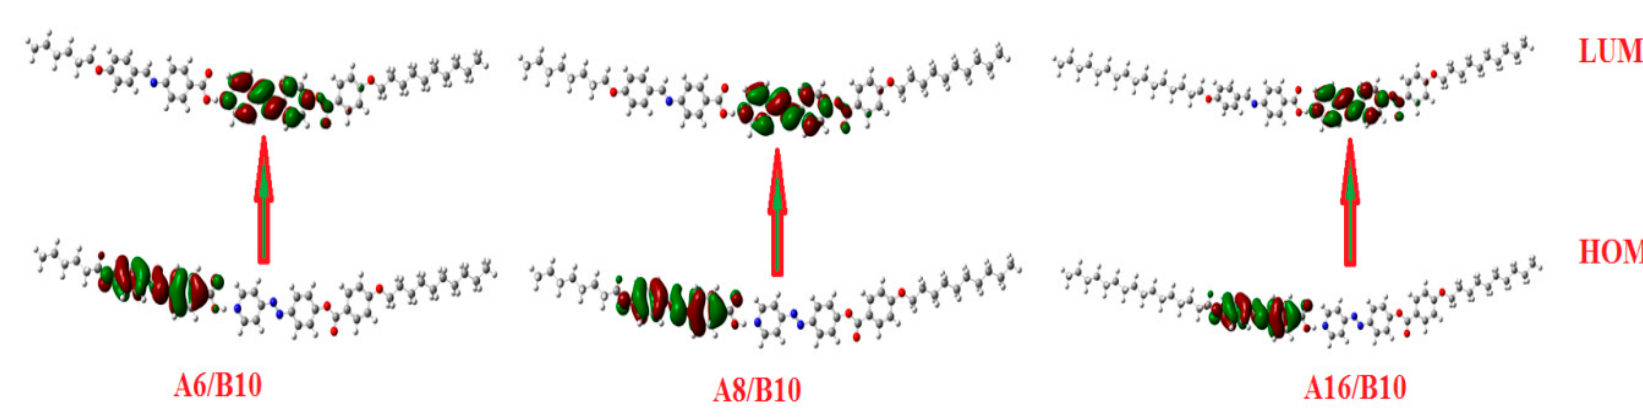
Figure 9. The estimated plots for frontier molecular orbitals of SMHBCs An / Bm.